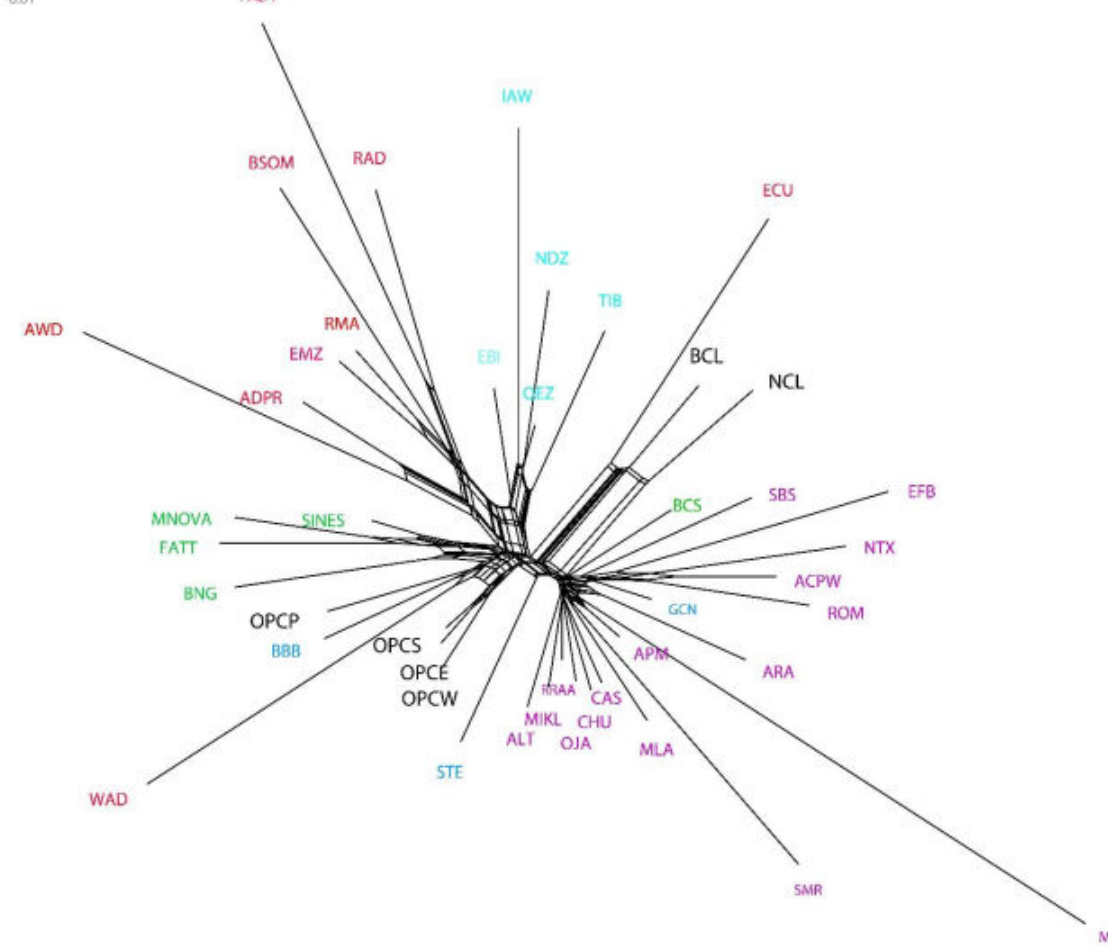
Figure 4. Neighbor network constructed from Nei’ genetic distances. In black the Colombian sheep breeds. Origin of breeds are indicated by colours: light blue, Asian, Middle East including Egypt; red, Africa; green, South-American native; blue, Caribbean; violet, European including